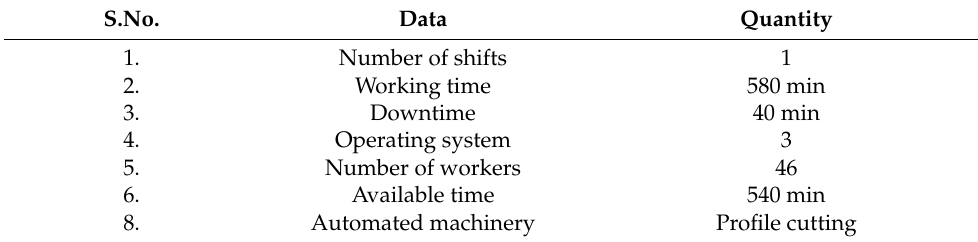
Table 4. Observed data of the shop